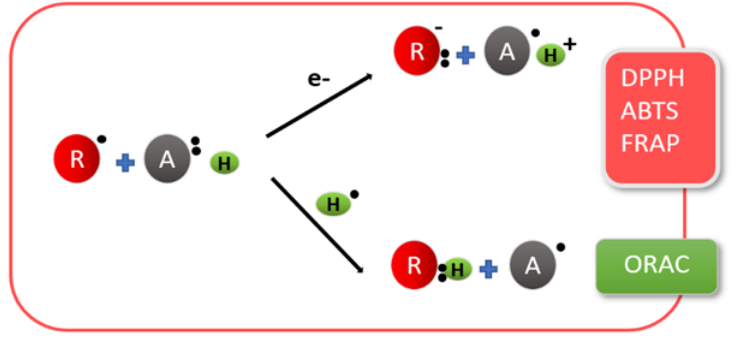
Figure 3. Methodologies used to determine antioxidant activities.